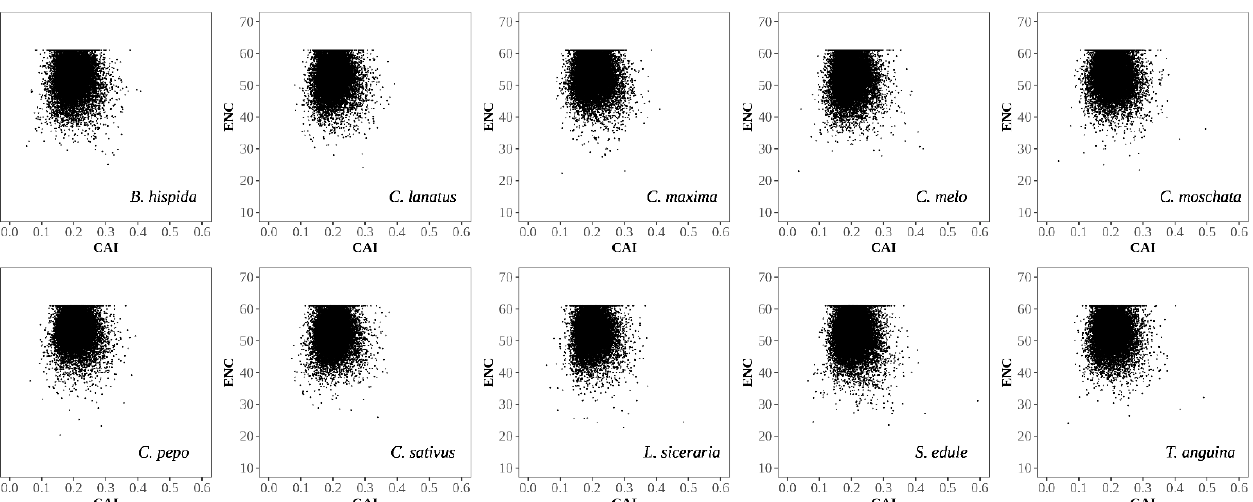
Figure 9. Plot of ENC vs. protein length in ten species of Cucurbitaceae. Note: the horizontal axis is the value of protein length, the vertical axis is the value of ENC.